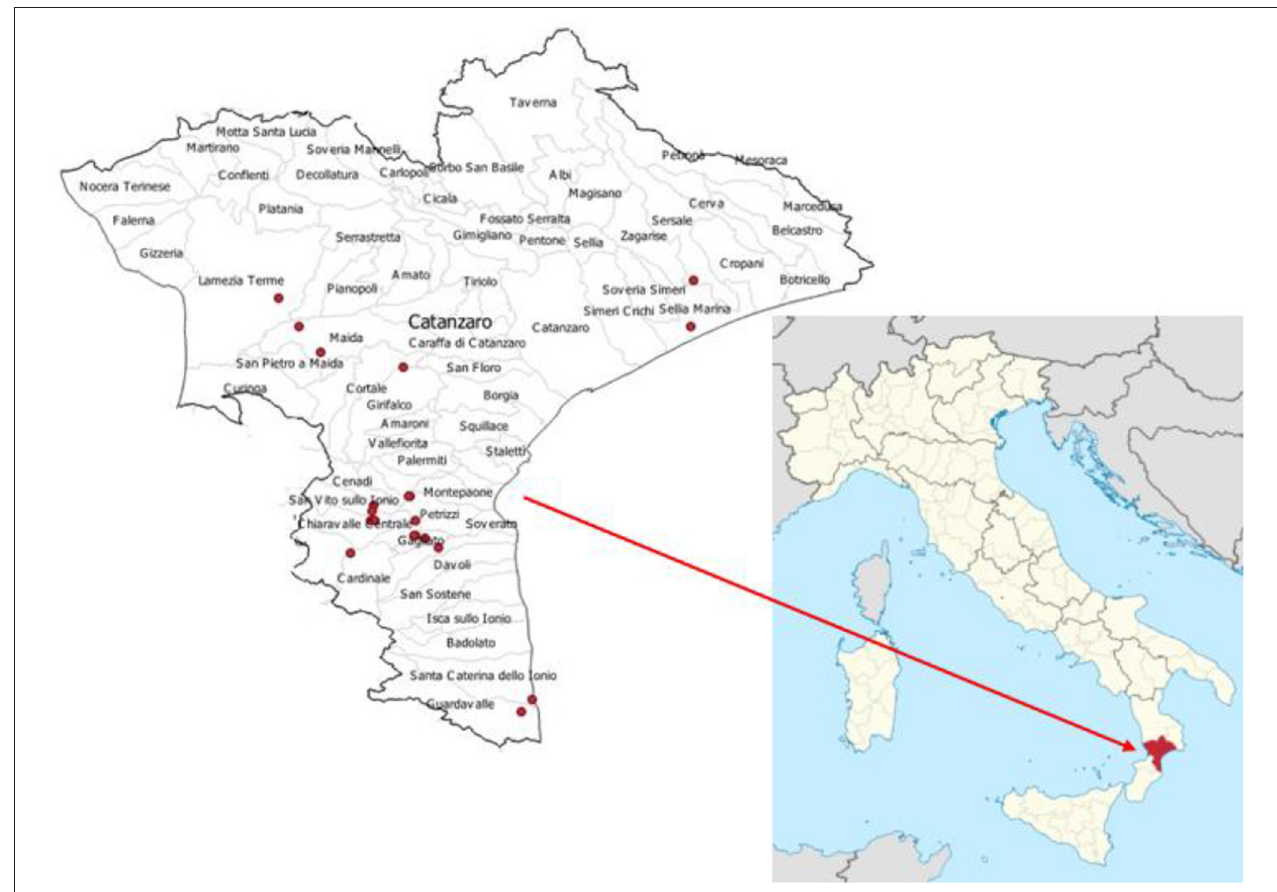
FIGURE 1 | Map of the study area and sampling locations. The lower right image shows the Italian peninsula and the Calabria region (in red). The image on the left, on the other hand, shows the places (red dots) where the farms are located, and the hay samples were